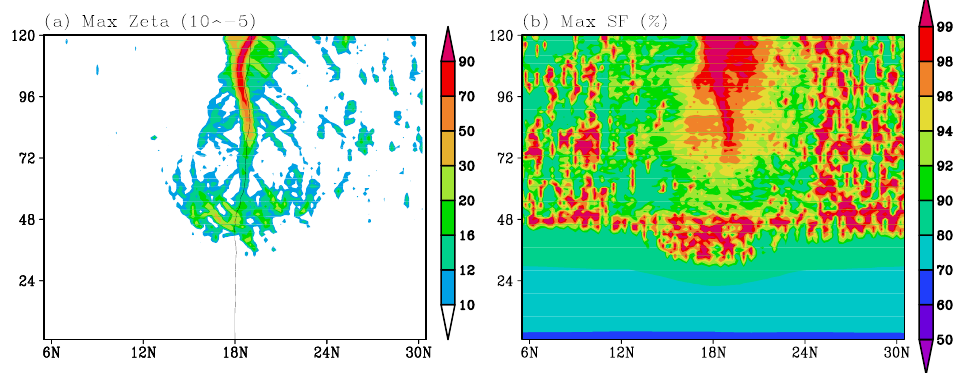
Fig. 14. Fujita diagram at high resolution: Time evolution of the 850hPa maximum relative vorticity (left; unit: 10 − 5 s − 1 ; derived from the 3-km horizontal grid output) and saturation fraction (SF) along each latitude. The x -axis indicates the latitude of the vorticity or SF maximum, and the y -axis is time (from Hour 25 to Hour 120). The thin curve in the left panel indicates the latitude where the zonal mean vertical shear between 200hPa and 850hPa is zero.